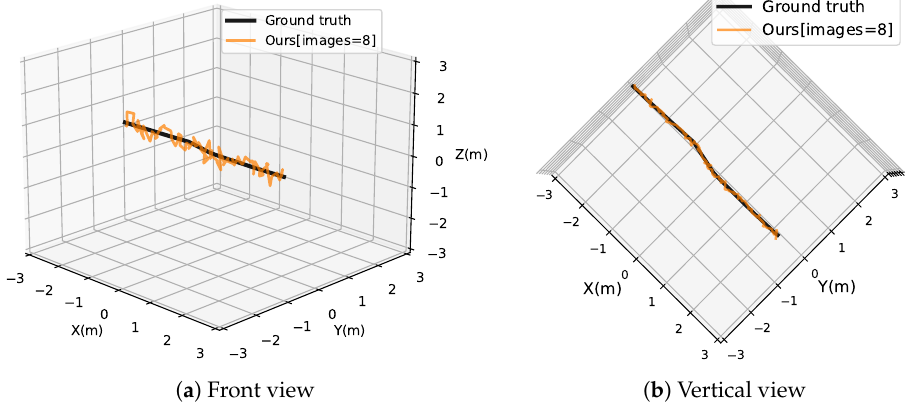
Figure 14. Paths of